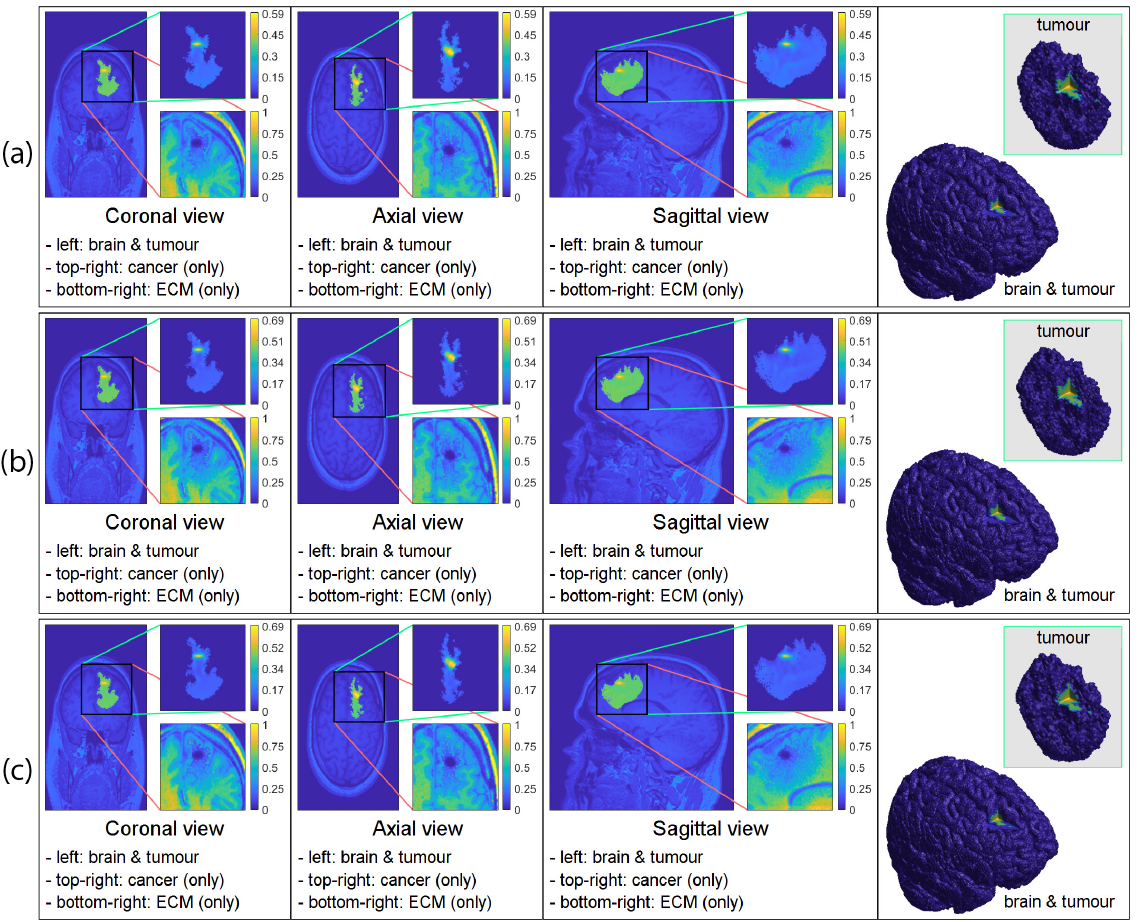
Figure 4. 3D computer simulation results ( a ) with only white–grey matter dependency ( r = 1); ( b ) with only DTI data used ( D G = 1); and ( c ) with both white–grey matter dependency and DTI data incorporated. To represent the simulation results, we use the same format as in Figure